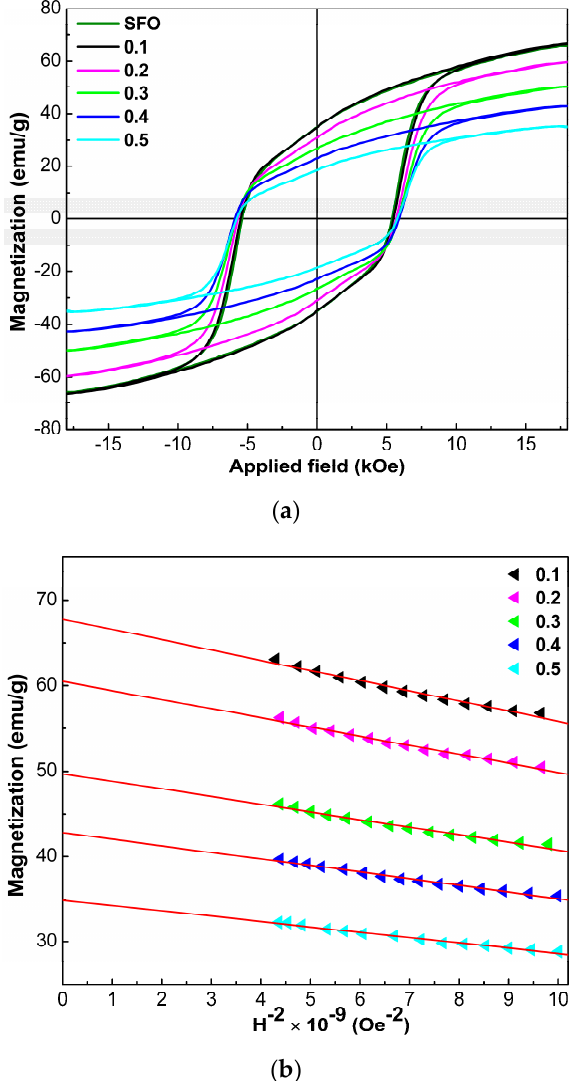
Figure 9. Magnetic hysteresis loops measured at room temperature ( a ) and linearized plots of the dependence of magnetization σ on H − 2 ( b ) SrFe 12-x Nd x O 19 (0 ≤ x ≤ 0.5) powders. Table 4. Magnetic hysteresis properties of SrFe 12-x Nd x O 19 (0 ≤ x ≤ 0.5)